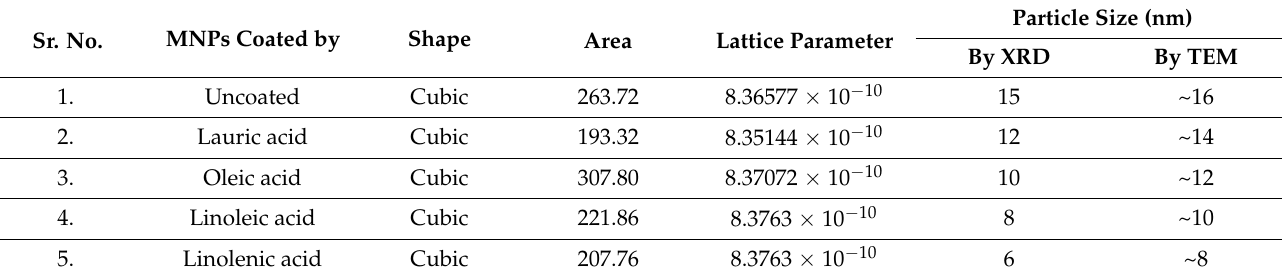
Figure 5. X-ray diffraction pattern of uncoated MNPs and surfactant-coated MNPs. Table 1. Results obtained from XRD